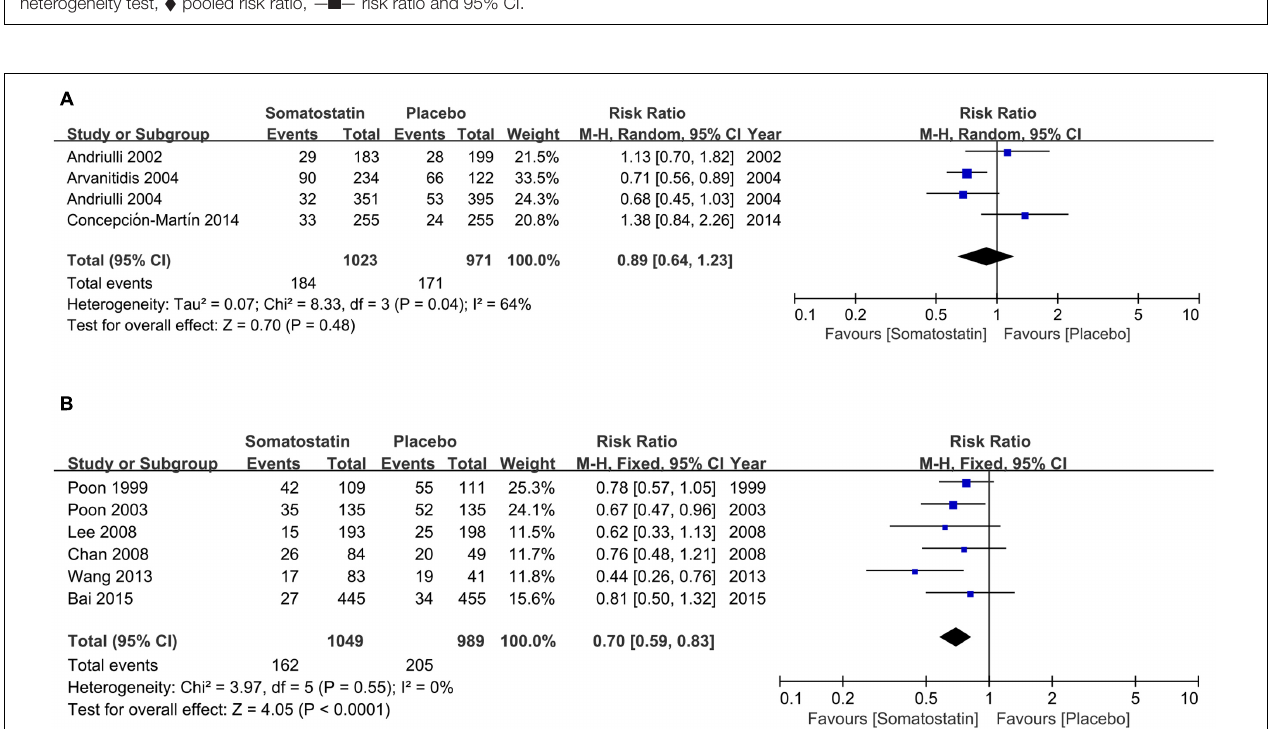
Frontiers in Pharmacology |